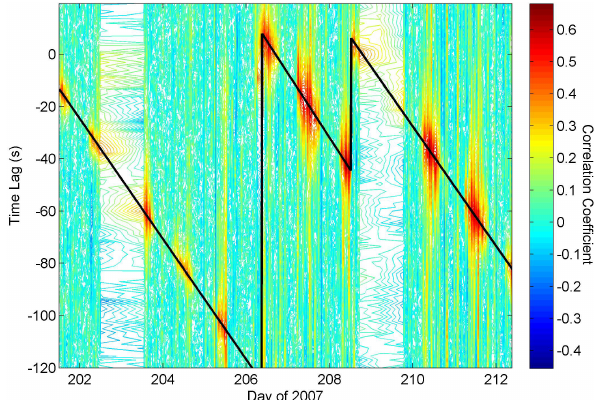
Fig. 1. Contour plot of the correlation coefficient as a function of the measurement time and the time lag between the vertical wind and isoprene mixing ratio. Large correlation coefficients are observed during the day when the isoprene flux is high. Due to acquisition of the wind and concentration data sets on two different computers using different software architectures, the time lag corresponding to the peak correlation drifts toward more negative values at a rate of 23s per day and is reset periodically when a new anemometer data file is initiated. The lag at the start of each new data file is ca. +8s, consistent with the transit time in the sample tube. The solid line is a fit to the lag yielding the peak correlation as a function of time and represents the lag value used to compute the isoprene